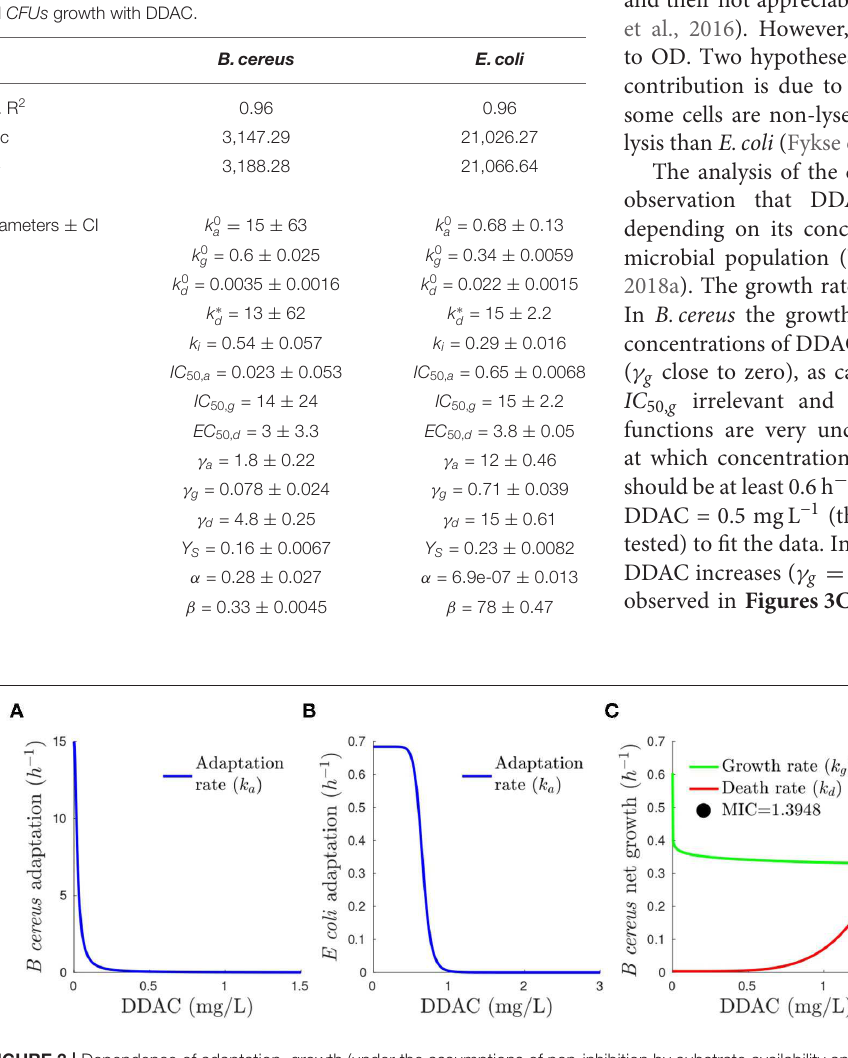
Frontiers in Microbiology |